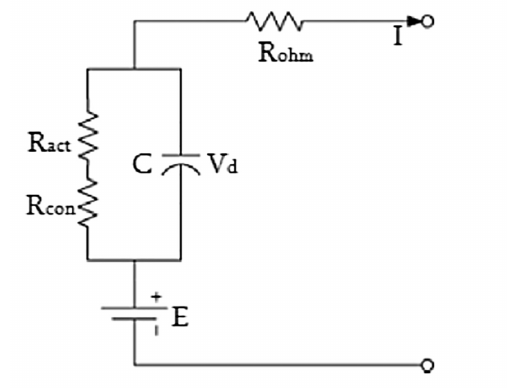
Figure 3. PEMFC equivalent